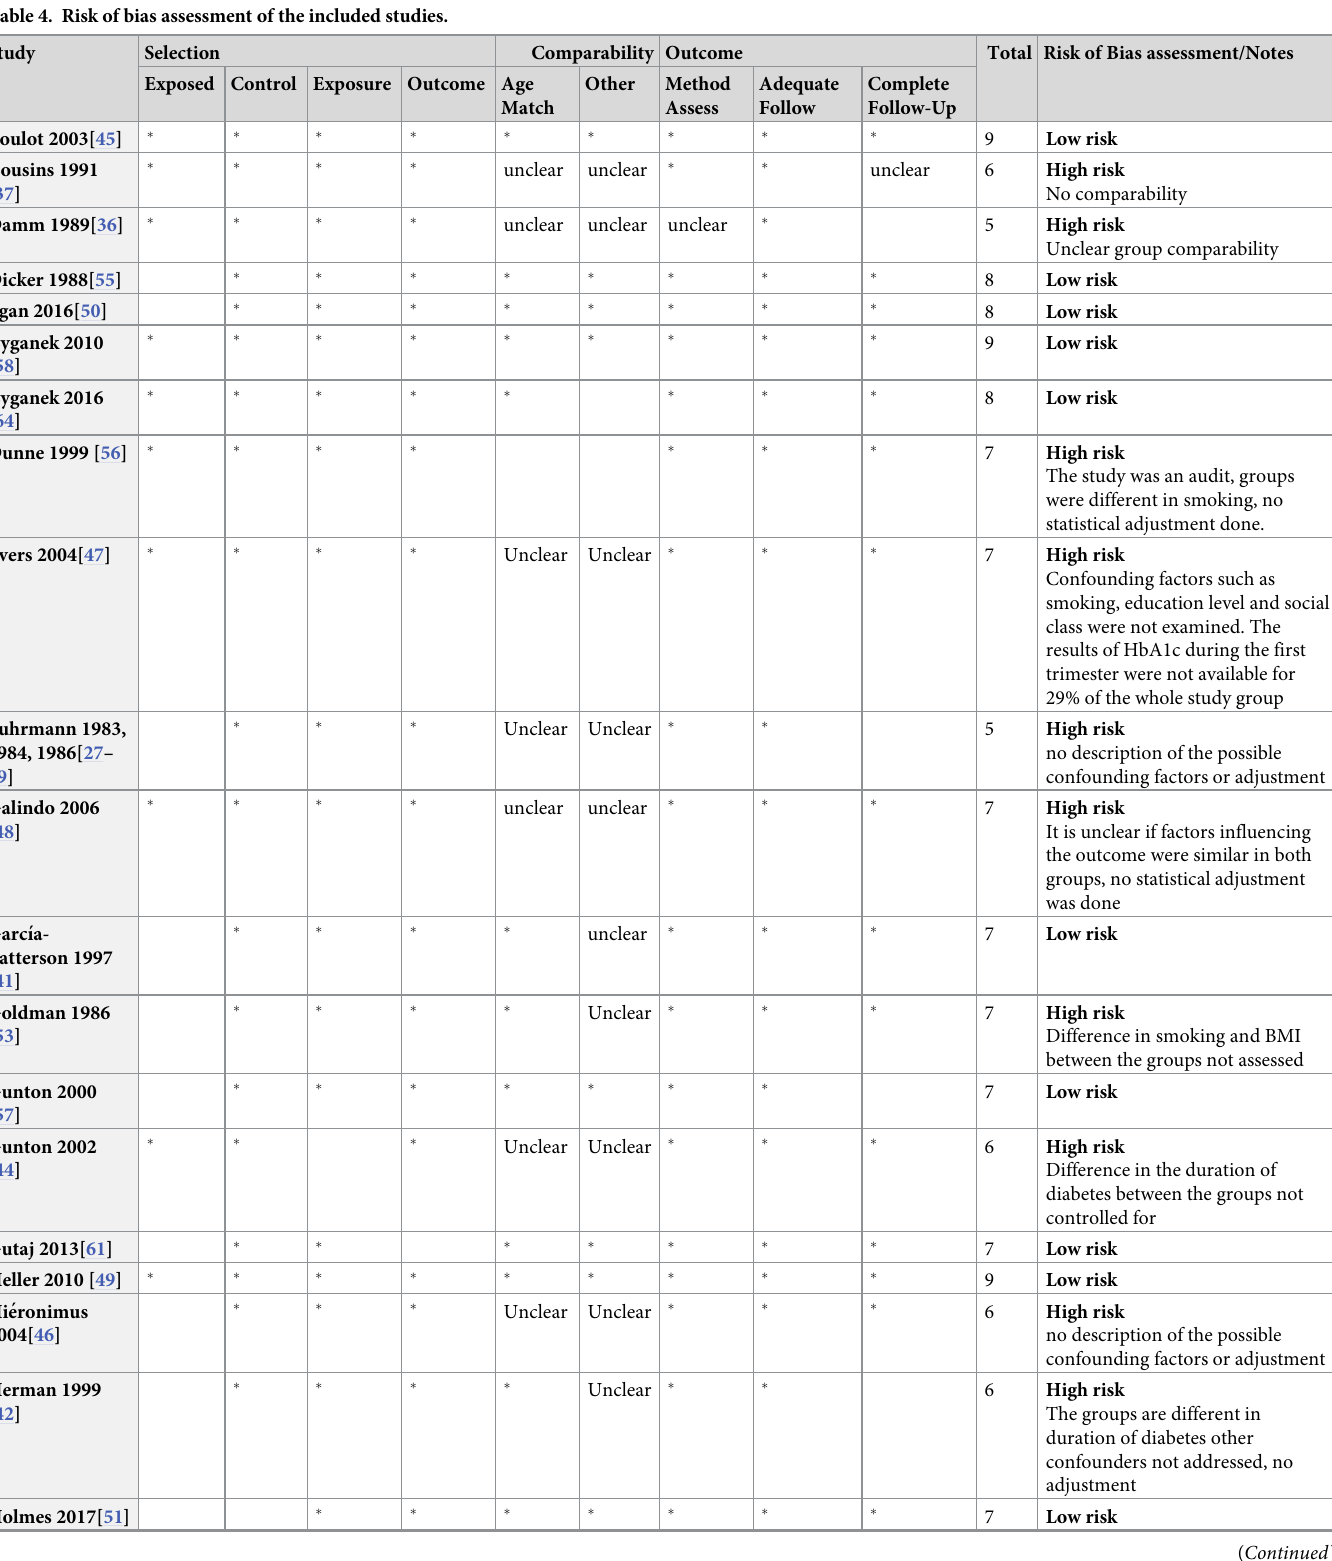
Table 4. Risk of bias assessment of the included